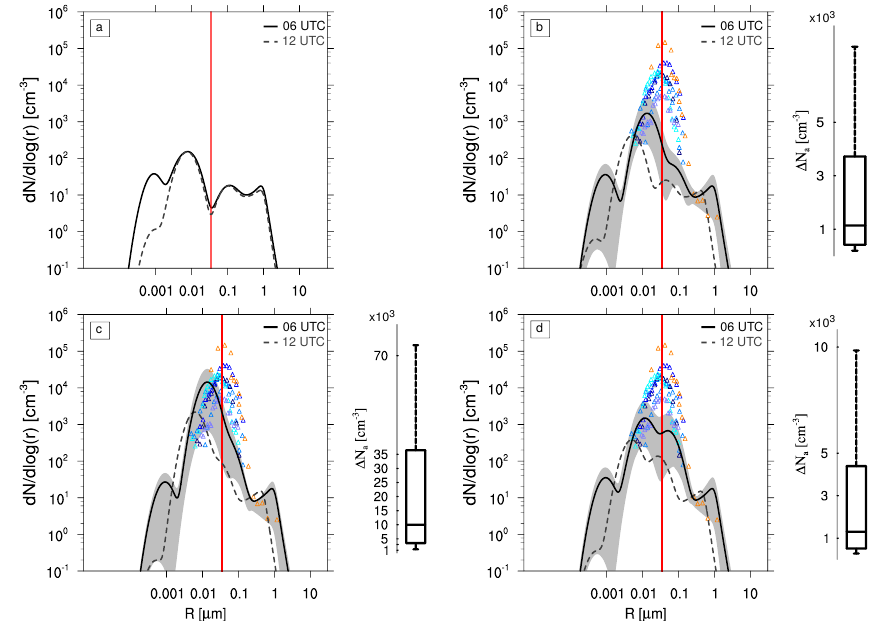
Figure 3. Mean aerosol size distributions of internally mixed aerosol for (a) clean , (b) ship , (c) ship10 and (d) ship10A are shown at 06:00 and 12:00UTC. At 06:00UTC size distributions were averaged bin-wise near the emission source and at 12:00UTC at a distance of 216km (see text for details). Red line marks the activation size threshold. In panels (b–d) : grey shaded region spans between the 10th and 90th percentiles at 06:00UTC; field study measurements are represented by coloured markers and include five size distribution measurements (different shades of blue) obtained by Hobbs et al. (2000) of vessels and one measurement (orange) obtained by Petzold et al. (2008); box plot representations of the total aerosol perturbation ( (cid:49)N a ) at 06:00UTC near the emission source with respect to the background (obtained from clean ) are shown in addition (note their different scale).